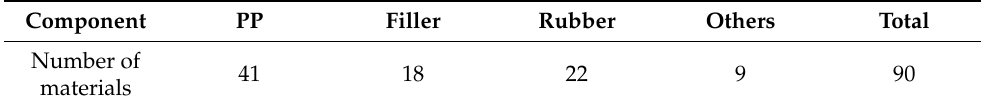
Table 1. The number of different materials used per PP composite component.